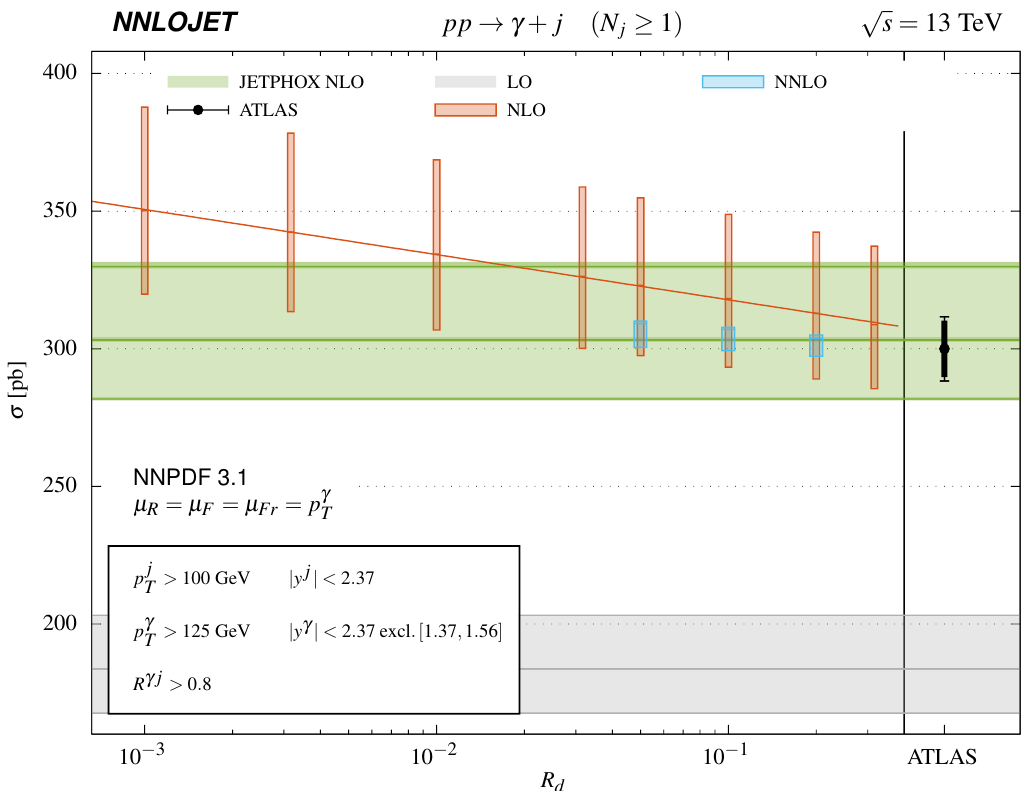
Figure 2 . Dependence of the total cross section for photon + jet production (ATLAS 13 TeV measurement [17]) at NLO and NNLO on the conesize R d of the inner dynamical cone used in the hybrid isolation procedure. All other isolation parameters are (cid:12)xed: " d = 0 : 1, n = 2, R = 0 : 4, E thres = 10 GeV, " = 0 : 0042. The line is a (cid:12)t of a function with form f ( R d ) = a T the NLO prediction at the central scale. The NLO prediction for (cid:12)xed cone isolation is obtained with the BFG parametrization [57] of the photon fragmentation functions, and computed with the JETPHOX code [36]. Its uncertainty band contains only variations of the factorization and renormalization scales, while the small fragmentation scale uncertainty is superimposed on the central and extremal values. The LO prediction is independent on the isolation